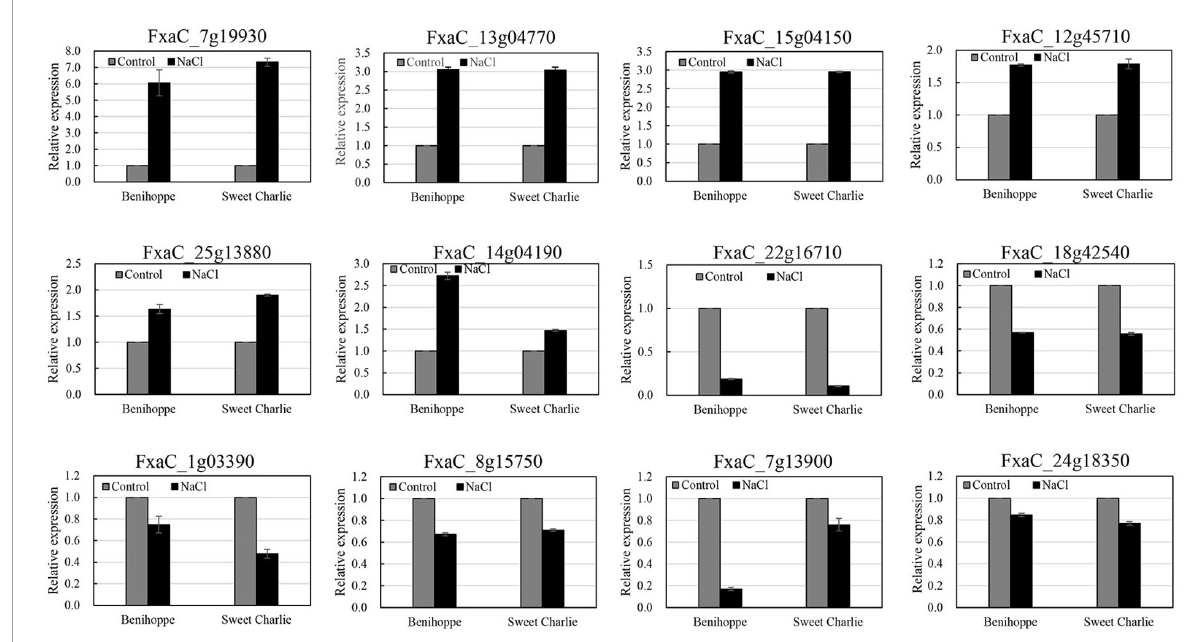
FIGURE5 Verification of differentially expressed genes by qRT-PCR. ‘Sweet Charlie’ and ‘Benihoppe’ plants with 6–7 leaves were treated with 0 mM (control) or 100 mM NaCl solution, respectively. After 12 h of treatment, the young leaves were collected for RNA extraction. Twelve genes were randomly selected to validate the RNA-seq results via qRT-PCR. Data are means ( ± SD) of three independent